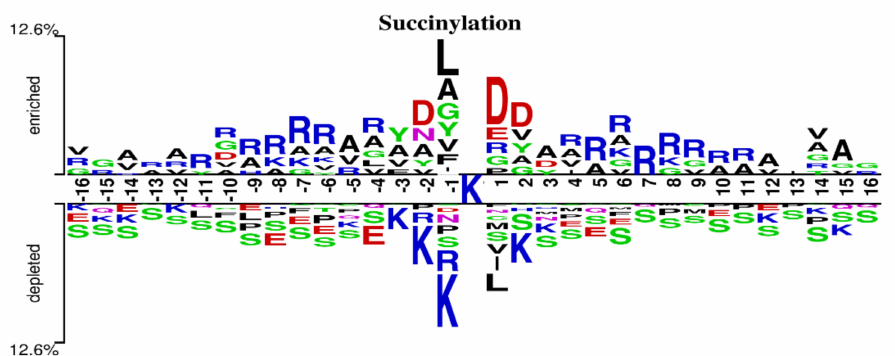
Figure 5. Two Sample Logos of positive and negative samples with L =